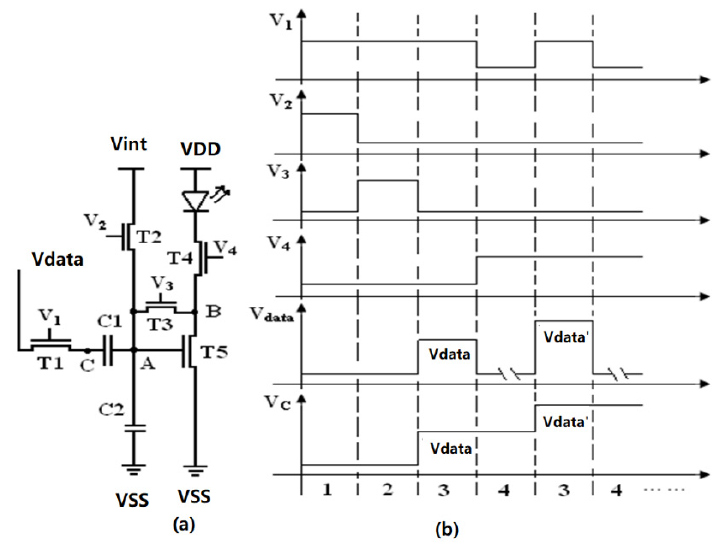
Figure 4. One-time detection method pixel circuit: ( a ) Schematic of the pixel circuit. ( b ) Timing diagram [112] (Reprinted with permission from ref. [112]. Copyright 2022 IEEE).